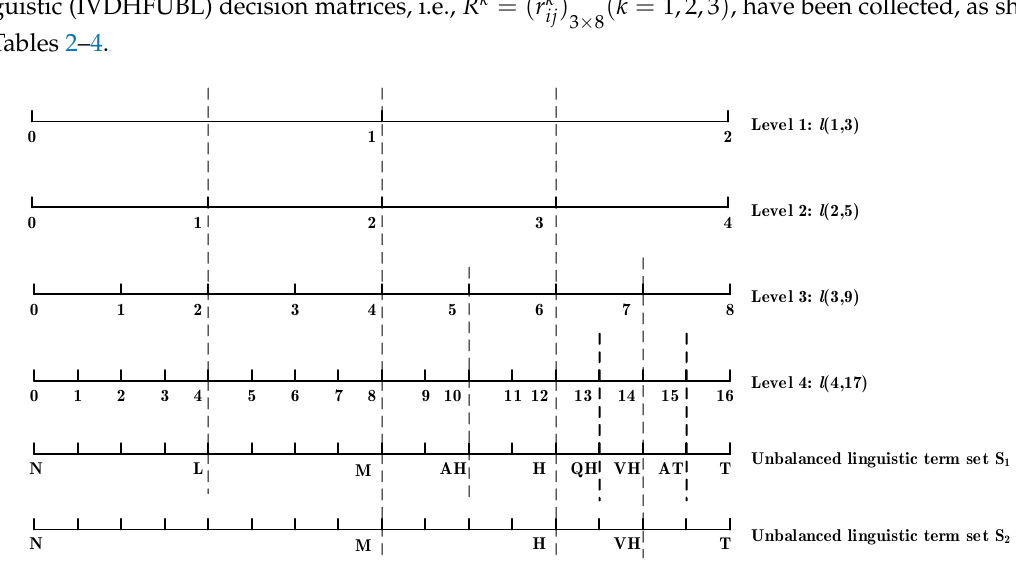
1 R E . provided by decision-maker 1